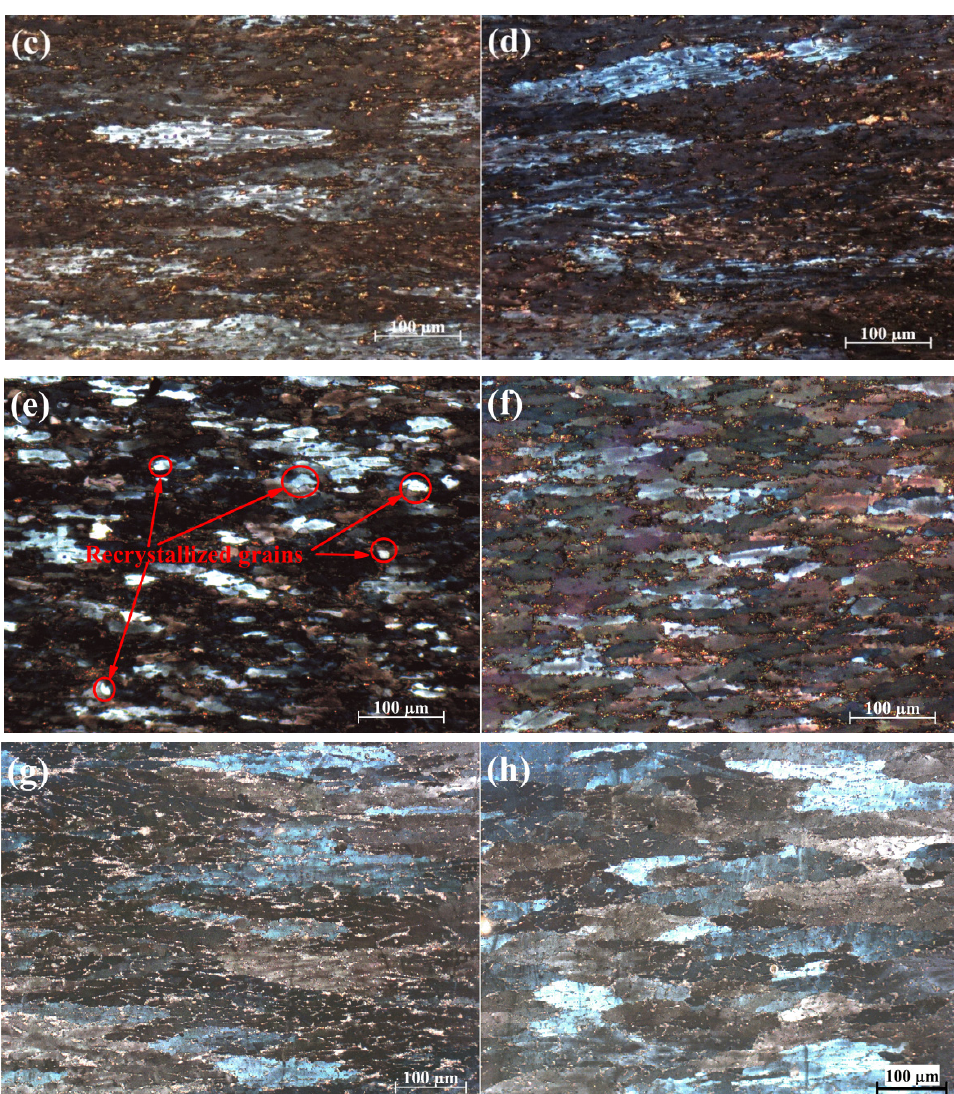
Figure 6. Grain microstructure of the investigated alloys AlCuYMg1 ( a , e ), AlCuErMg1 ( b , f ), AlCuYMg2 ( c , g ), and AlCuErMg2 ( d , h ) after compression at 440 °C and a strain rate of 15 s − 1 ( a – d ); after compression at 540 °C and a strain rate of ( e , g ) 15 s − 1 and ( f , h ) 0.1 s − 1 .